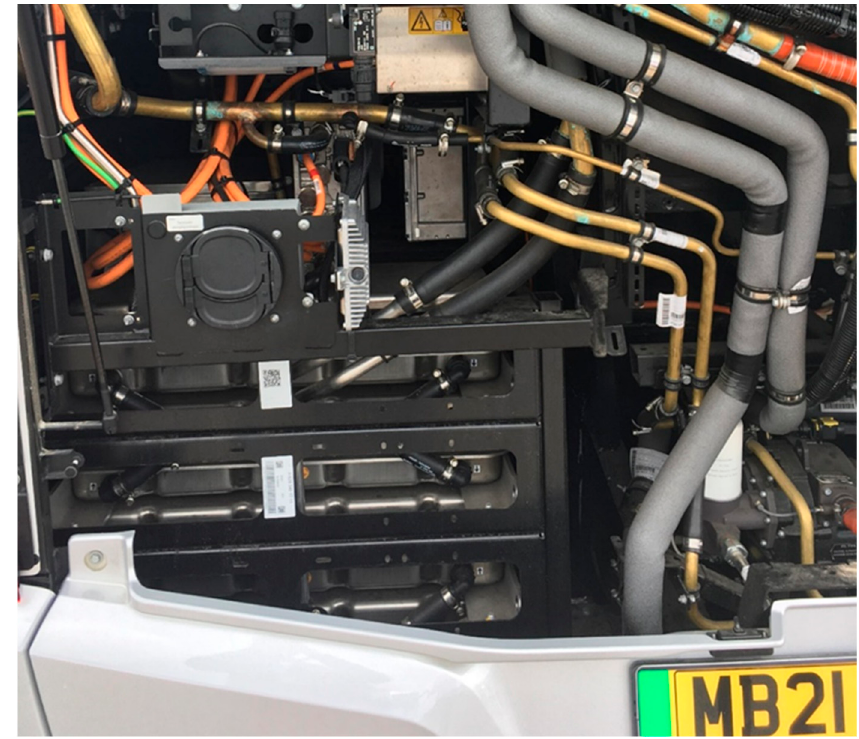
Figure 15. Mercedes Benz E ‐ citaro electric bus. Photo taken by the author.